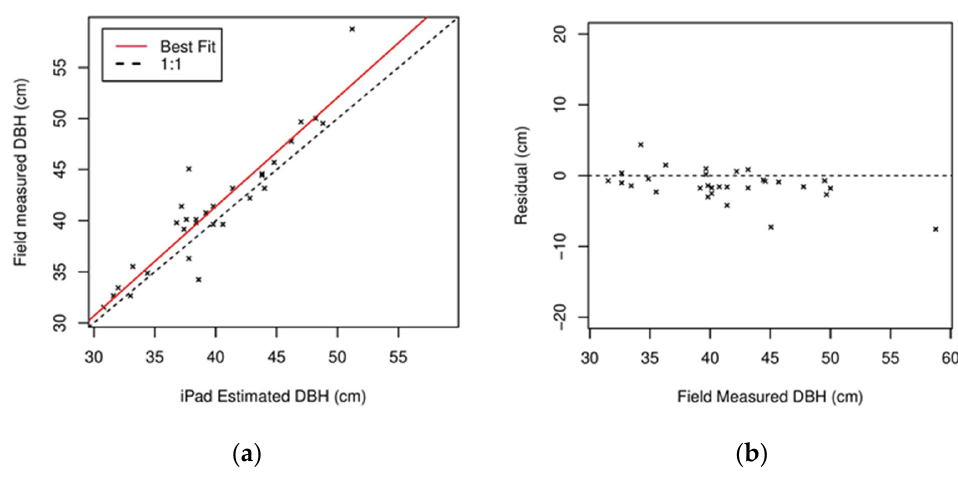
Figure 17. Forest stand measurements: ( a ) DBH comparison between iPad LiDAR to field measurements (tape measure). ( b ) Regression plots for DBH from iPad LiDAR data residuals for the estimated DBH.